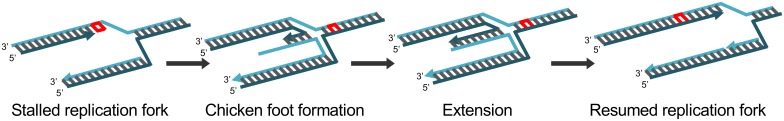
Illustration of replication fork remodeling in template switching.A stalled replication fork is shown with damage on the leading strand. Rad5 rearranges the DNA such that the stalled primer strand base pairs with the newly synthesized primer strand from the lagging strand. This results in a chicken foot intermediate. In this configuration, classical DNA polymerases can extend the stalled primer strand resulting in error-free bypass of DNA damage. Once replication has progressed beyond the site of damage, the replication fork can be reestablished and conventional DNA replication can resume.